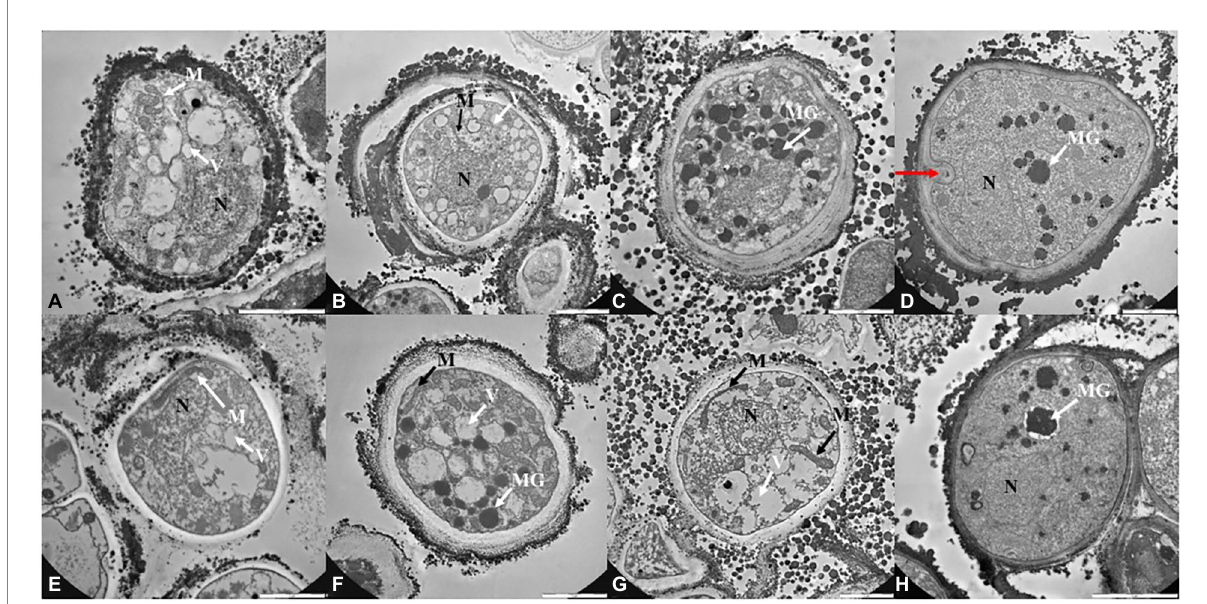
FIGURE 5 TEM images of C. antarcticus cells grown on (A) MEA (no salt, control), (B) 50 mM, (C) 120 mM and (D) 145 mM of Mg-perchlorate; (E) MEA (no salt, control), (F) 50 mM, (G) 150 mM, and (H) 200 mM of Ca-perchlorate. Scale bar: 2 μ m. N, nucleus; M, mitochodrion; DM, damaged mitochodrion; CW, cell wall; LB, lipid body; V, vacuoles; MG, melanin granules; red arrow, cell wall